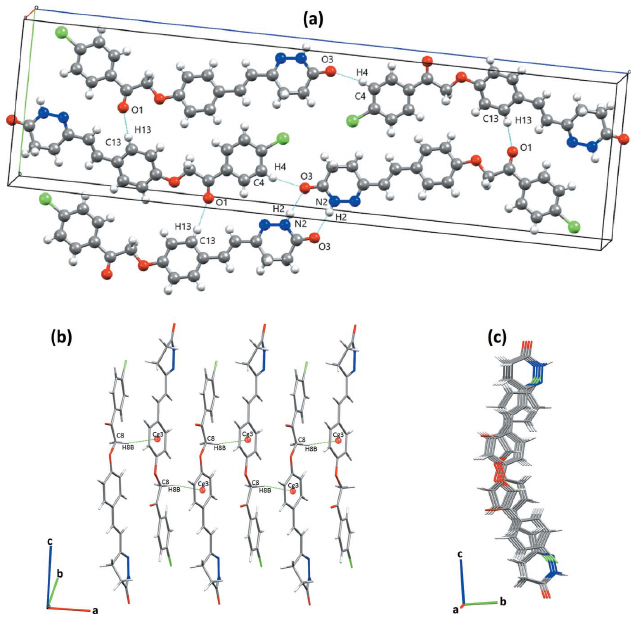
Figure 3 ( a ) Hirshfeld surfaces of the title molecule mapped over ( a ) d norm , ( b ) d e and ( c ) d i .